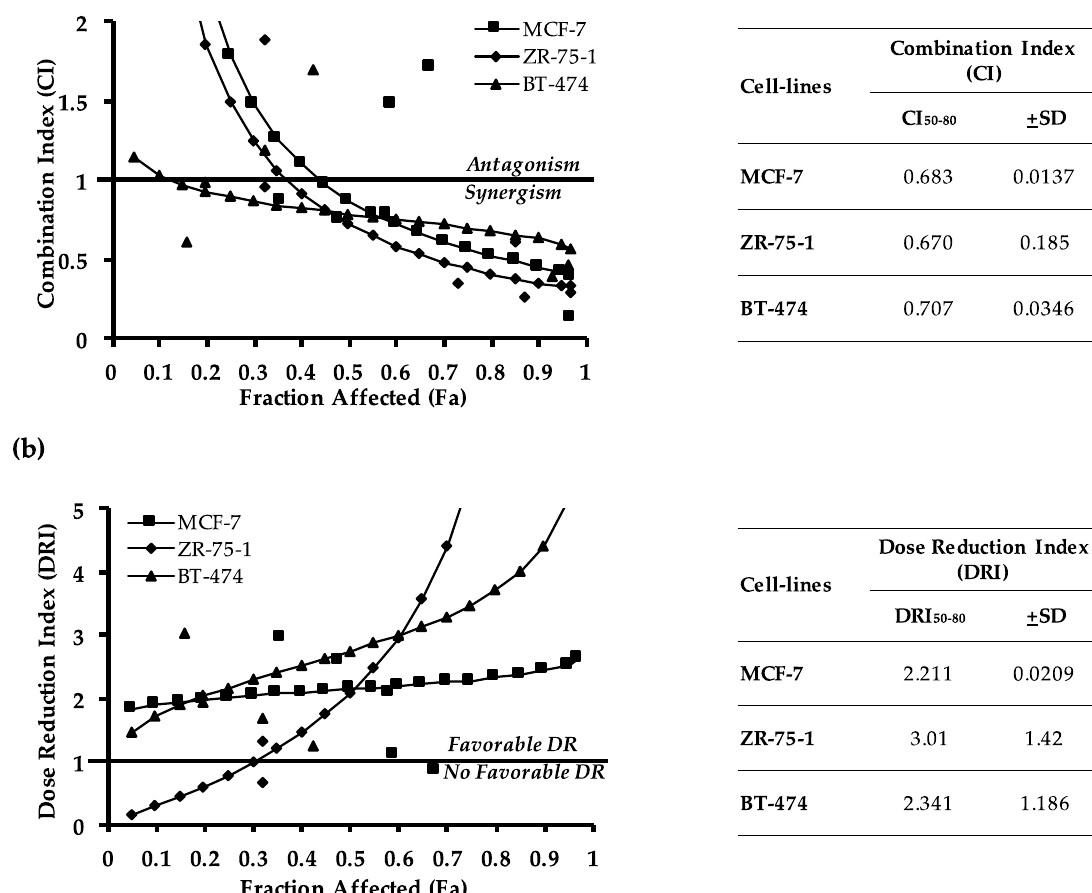
Figure 2. AMPC exhibits synergistic combination with doxorubicin and promotes effective dose reduction of doxorubicin. ( a – b ). MCF-7, ZR-75-1 and BT-474 cells were treated with increasing doses of doxorubicin and AMPC at a fixed ratio based on the IC 50 values of the individual drugs for 72 h in monolayer culture (MCF-7 1:20, ZR-75-1 1:20, BT-474 1:25). ( a ) Combination index (CI) and ( b ) dose reduction index (DRI) were tabulated using CalcuSyn software by Chou-Talalay. CI 50-80 and DRI 50–80 denotes average combination index and average dose reduction index respectively at 50–80% cell